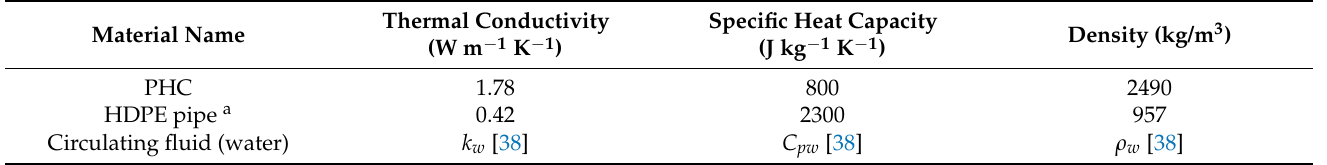
Table 3. The relevant properties of materials used in the numerical